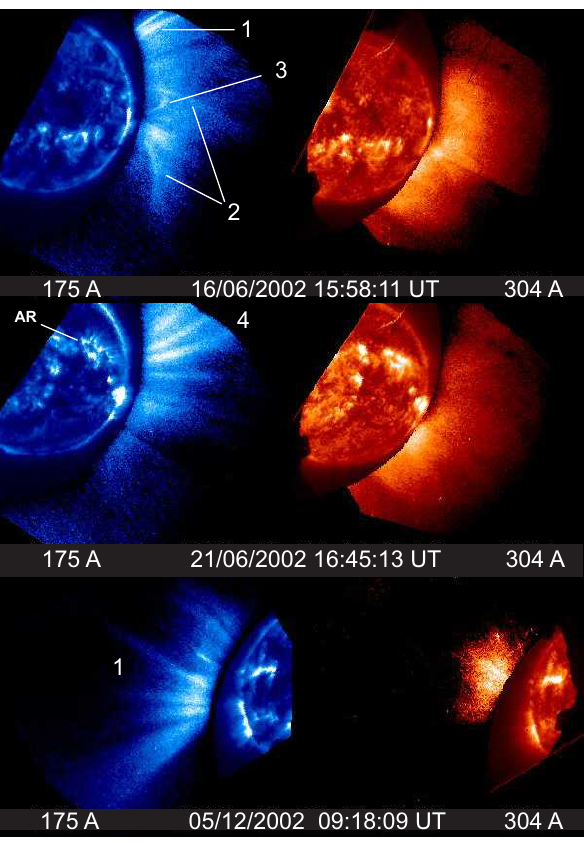
Fig. 4. Specific coronal features observed by the SPIRIT EUV coro- nagraph in the 175 and 304 ˚A bands: 1 – radial rays, 2 – non-radial rays, 3 – a rising loop, 4 – a fan of rays linked with the active region at the